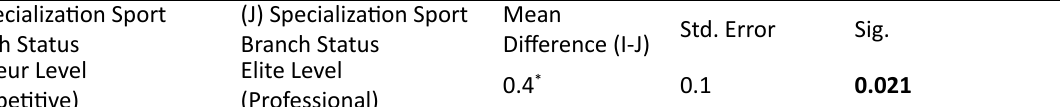
Table 6. One-Way ANOVA Test Results According to Specialty Sports History Variable ANOVA Fear of COVID-19 Scale